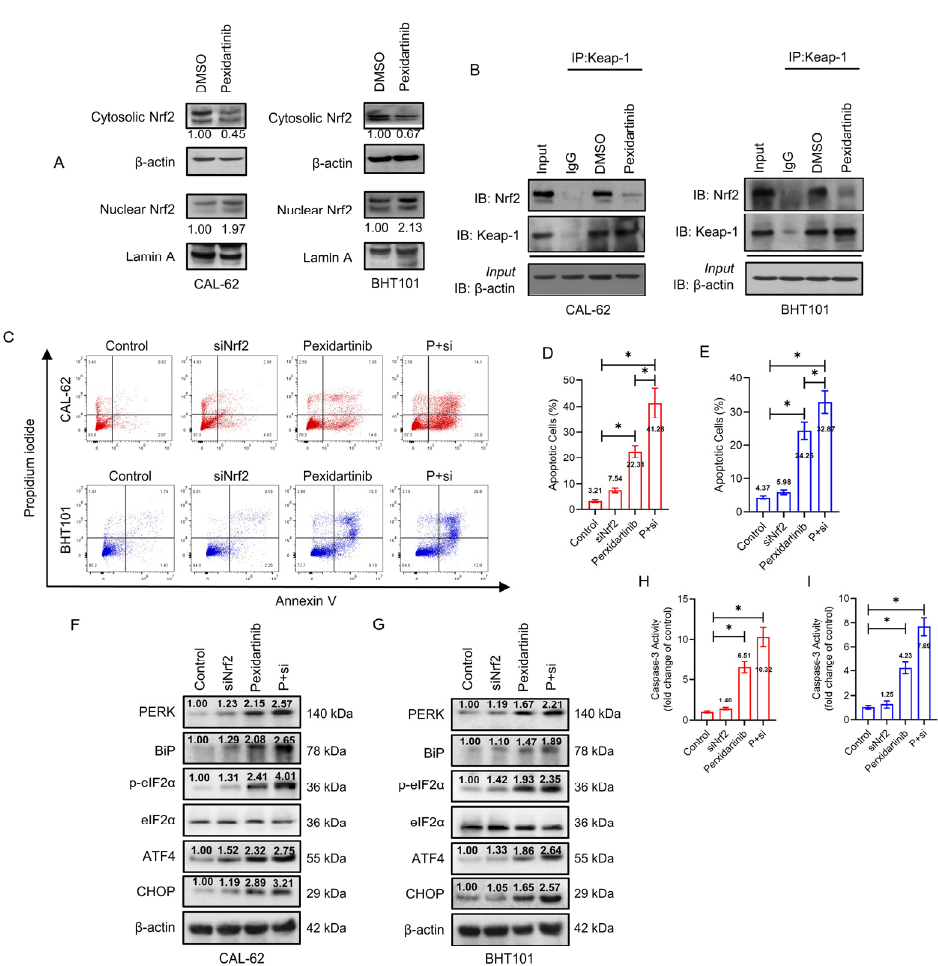
Figure 5. Knockdown of Nrf2 enhances the anti-ATC effects of pexidartinib. ( A ) Western blot analysis for the detection of cytosolic and nuclear levels of Nrf2 expression after pexidartinib administration in CAL-62 and BHT101 cells. ( B ) Co-immunoprecipitation (co-IP) determination to detect interaction of Nrf2 with Keap-1 after pexidartinib administration in CAL-62 and BHT101 cells. ( C – E ) Apoptotic cells were detected in CAL-62 and BHT101 cells after knockdown of Nrf2. ( F , G ) PERK-dependent molecular pathways protein alteration on ER stress detected by Western blot after administration of pexidartinib in Nrf2-knockdown CAL-62 and BHT101 cells. ( H , I ) Caspase-3 activity detected after administration of pexidartinib in Nrf2-knockdown CAL-62 and BHT101 cells. The original blots can be found in Figure S1. Data are presented as mean ± SD in at least three independent experiments (significance is presented as * when p < 0.05).